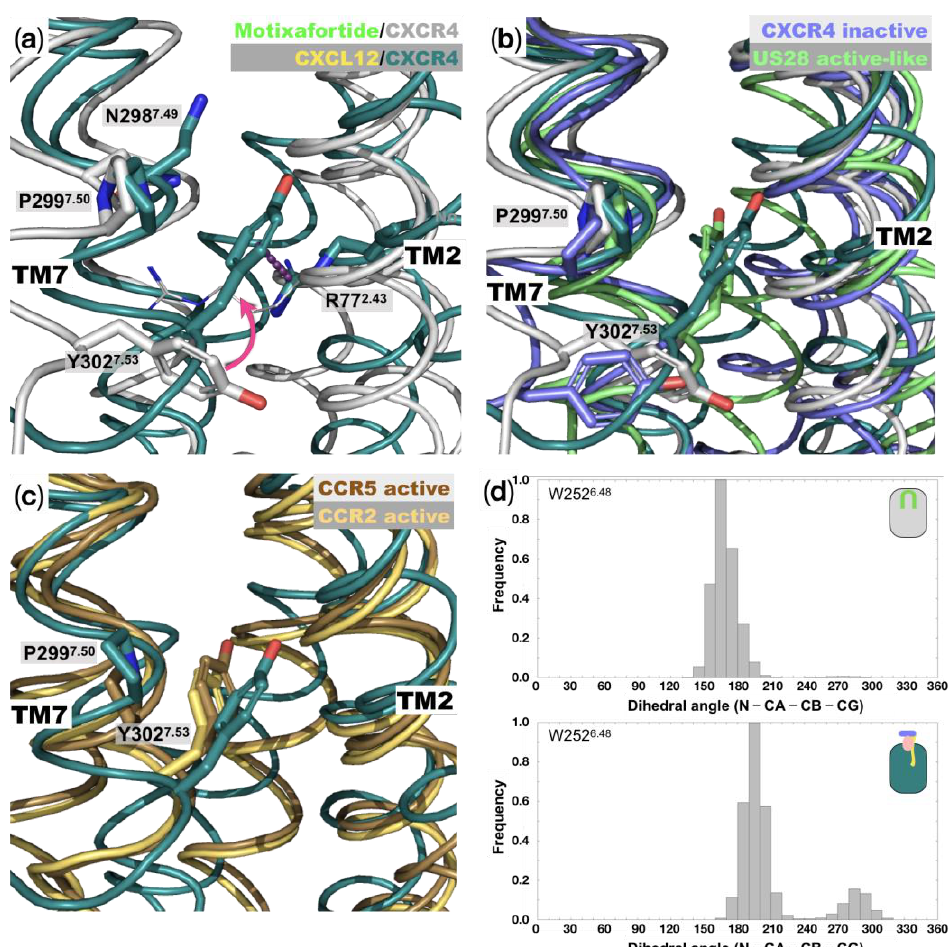
Figure 3. Conformations at the NPxxY and toggle switch motifs: ( a ) Representative structures of the final stages of the MD simulation for the motixafortide/CXCR4 and CXCL12/CXCR4 protein complexes. Residues that are part of the highly conserved NPxxY motif, which has been implicated in GPCR activation, are indicated (N298 7.49 , P299 7.50 , and Y302 7.53 ); TM6 is not depicted in the figure. The position of residue Y302 7.53 changes significantly in the agonist-bound CXCR4 complex (colored teal), while in the antagonist-bound system (grey) it remains very similar to the starting conformation (see magenta arrow). ( b ) Comparison of the NPxxY motifs of the two CXCR4 complexes investigated here with the inactive structure of CXCR4 (4RWS.pdb) and the active-like structure of the viral chemokine receptor US28 (4XT3.pdb). While the sidechain position of residue Y302 7.53 in the motixafortide/CXCR4 complex resembles that of the inactive CXCR4 structure, the sidechain in CXCL12/CXCR4 moves towards the interior of the helical bundles, as in the case of the active- like GPCR structure. ( c ) Superposition of the agonist-bound system (CXCL12/CXCR4) with the active structures of the closely related CCR5 (7F1S.pdb) and CCR2 (7XA3.pdb) chemokine receptors, showing the resemblance in the conformation of Y302 7.53 from the highly conserved NPxxY motif. ( d ) The dihedral angle defined by the N-CA-CB-CG atoms from the toggle switch residue, W252 6.48 , are shown for the antagonist-bound and agonist-bound CXCR4